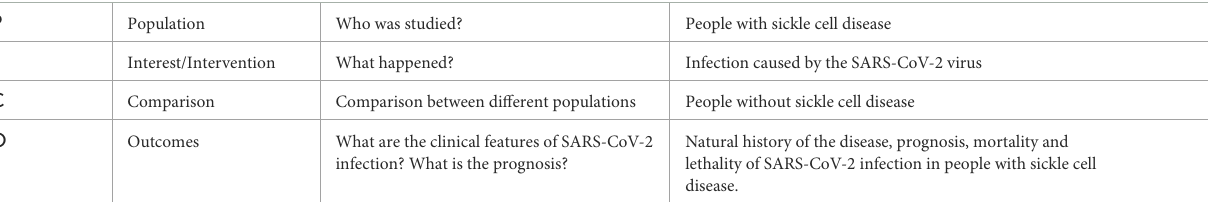
TABLE 1 Research question definition by following PICO